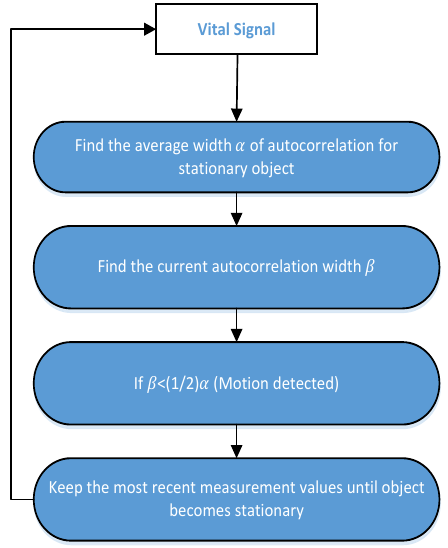
Figure 5. Random body motion detection algorithm.